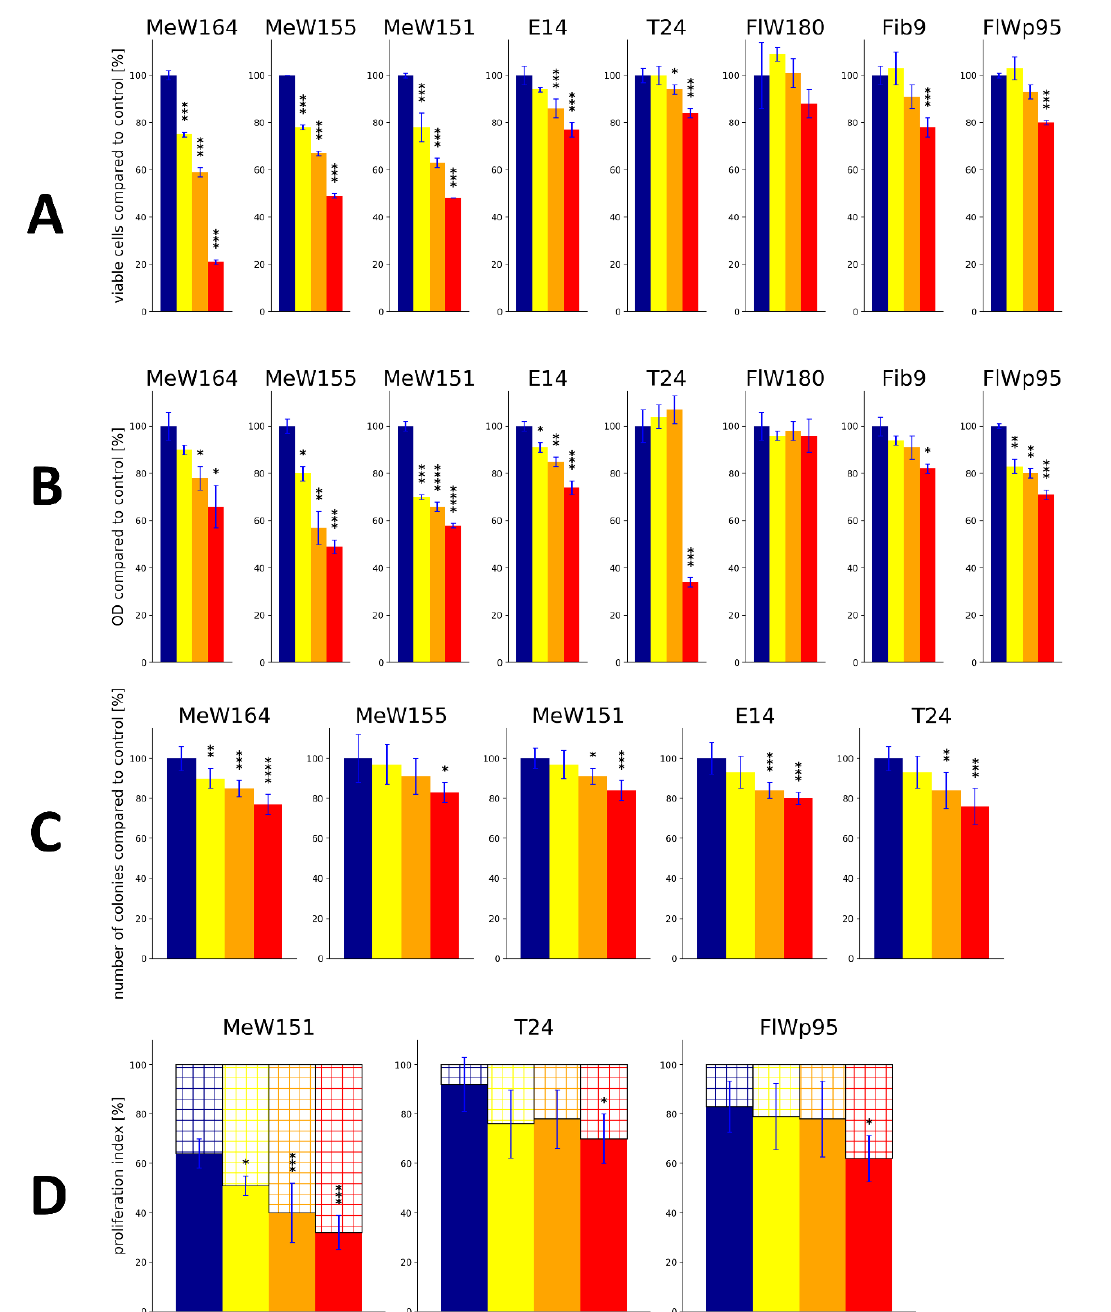
Figure 5. The cellular pharmacological effects of AA3266 in selected cell lines. ( A ) Number of cells counted in haemocytometer (data taken from Ref. [29]) ( B ) Results of the MTT assay. ( C ) Effect on the extent of the colony formation. ( D ) Effect on the expression of the Ki67 protein. The data are expressed as percentage of the values found for the control. Bar colouring corresponds to the concentration of AA3266 (red—100 µM; orange—50 µM; yellow—25 µM; blue—0 µM, control). Cell lines designations given in text. Blue thin bar shows standard deviation. The data come from two independent experiments done in triplicate. The asterisks denote statistical significance of the difference between the given value found for the given concentration and the control (* p ≤ 0.05, ** p ≤ 0.01, *** p ≤ 0.001, **** p < 0.0001). The statistical analysis used is the one-way ANOVA with post-hoc Dunnett test at significance level α = 0.05.